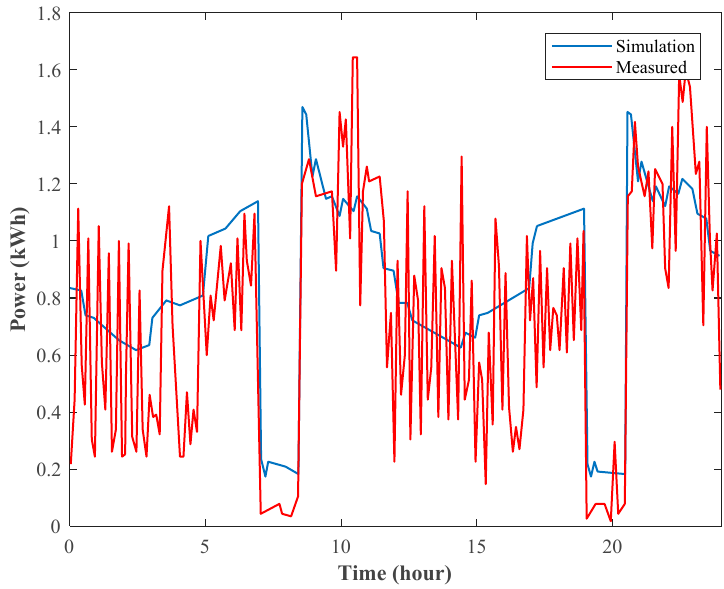
Figure 5. Simulated and measured hourly electricity usage of building 3.